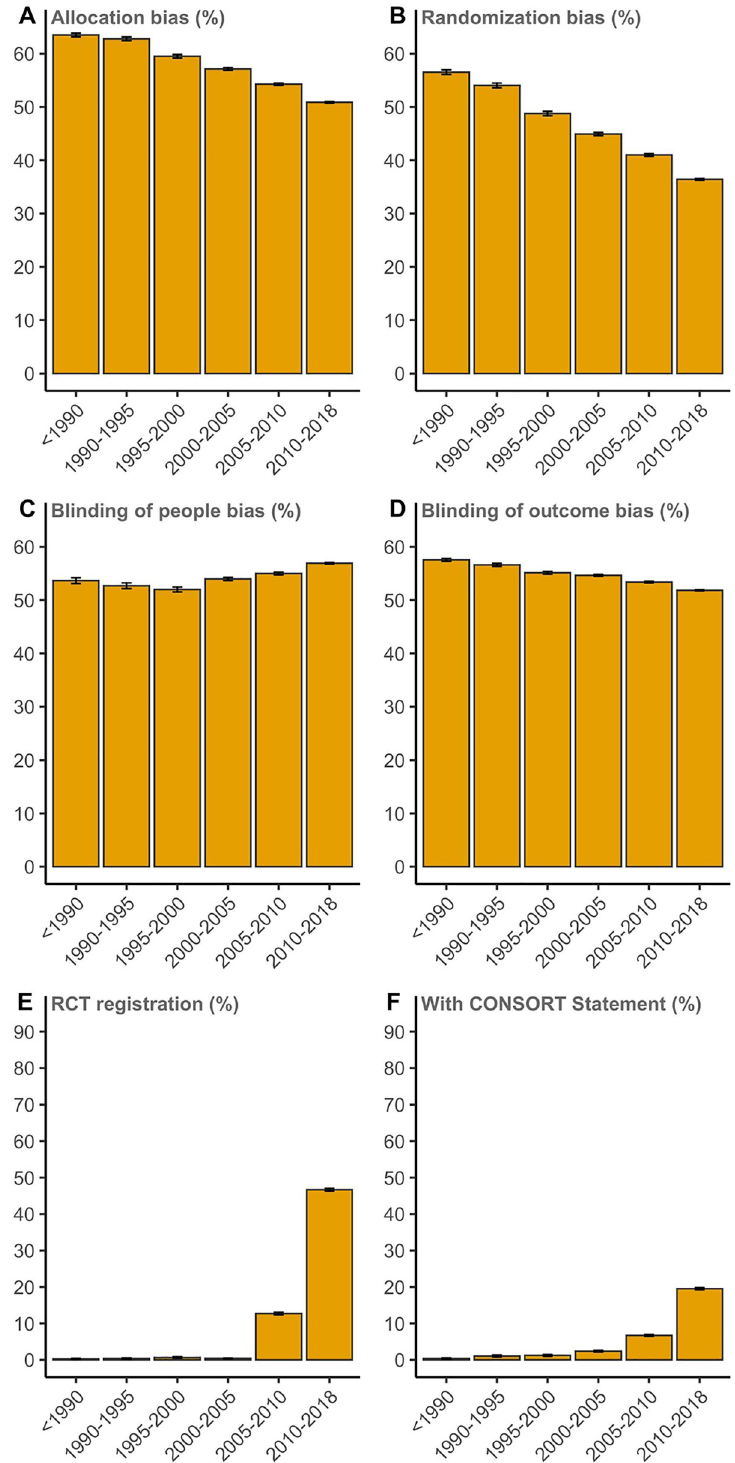
Fig 3. Risk of bias due to inadequate allocation concealment (A) , random sequence generation bias (B) , the bias in blinding of patients and personnel (people) (C) , the bias in blinding of outcome assessment (D) , RCT registration (E) , and reporting of the CONSORT Statement (F) for all RCTs plotted over time. The indicated stratum range is up to but not including the last year. Raw data are available via DOI 10.5281/zenodo.4362238. RCT, randomized controlled trial.